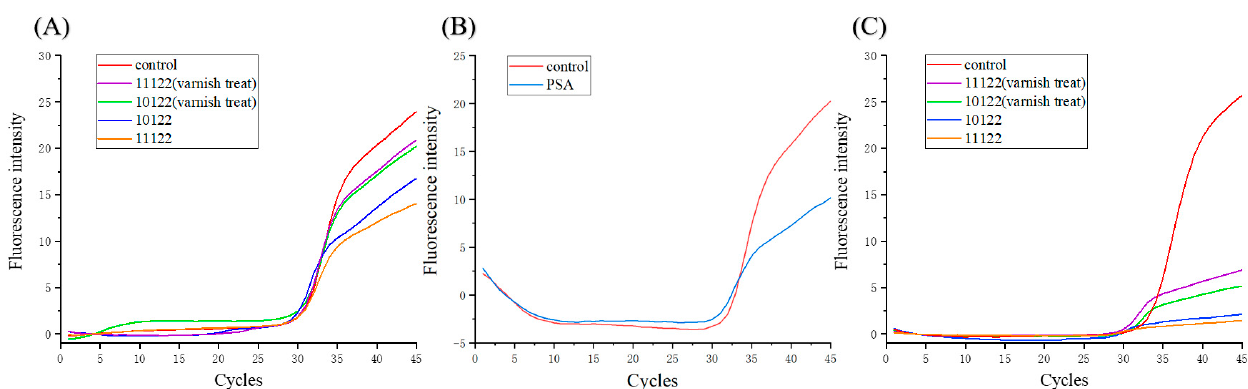
Figure 4. The typical qPCR curves after the PCR reagent contacted photosensitive resins ( A ) and PSA ( B ) for 12 min. ( C ) The qPCR curves of the PCR reagent in which photosensitive resins were immersed for PCR thermocycling.